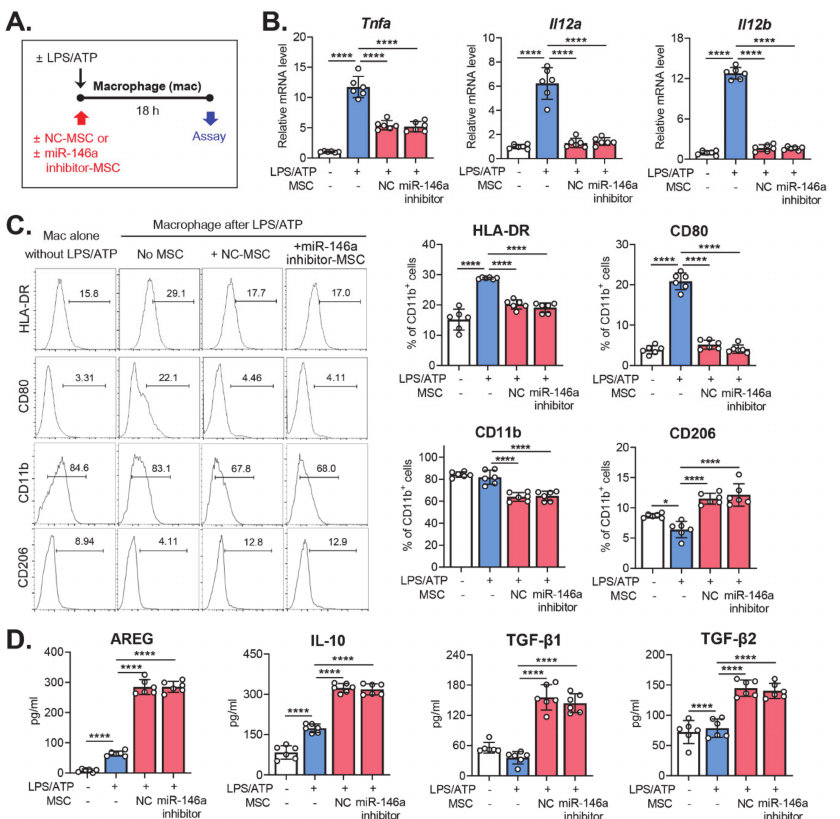
Figure 3. Absence of e ff ects of miR-146a inhibition on the activity of MSCs in terms of modulating macrophage polarization. ( A ). Scheme for experiments. Macrophages were activated by serial treatment with LPS and ATP and then co-cultured with MSCs that had been transfected with a miR-146a inhibitor (miR-146a inhibitor-MSC) or a negative control (NC-MSC). Eighteen hours later, the macrophages were evaluated for inflammatory activation status. ( B ). Real-time RT-PCR for pro-inflammatory cytokines in macrophages. Shown are the mRNA levels in LPS / ATP-activated macrophages relative to LPS / ATP-untreated macrophages. ( C ). Flow cytometric analysis for surface expression of the MHC class II molecules HLA-DR, CD80, CD11b, and CD206 on macrophages. ( D ). ELISA of the secreted levels of immunoregulatory proteins in the cell-free culture supernatant. **** p < 0.0001, as analyzed by one-way ANOVA and Tukey’s multiple comparisons